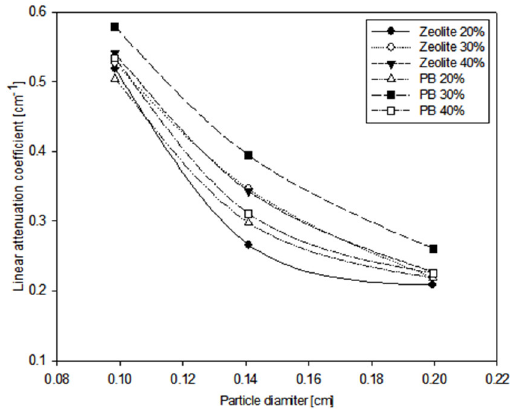
Figure 20. Linear attenuation coefficient of cesium absorption nonwoven for cesium; γ-ray energy = 0.662 MeV.